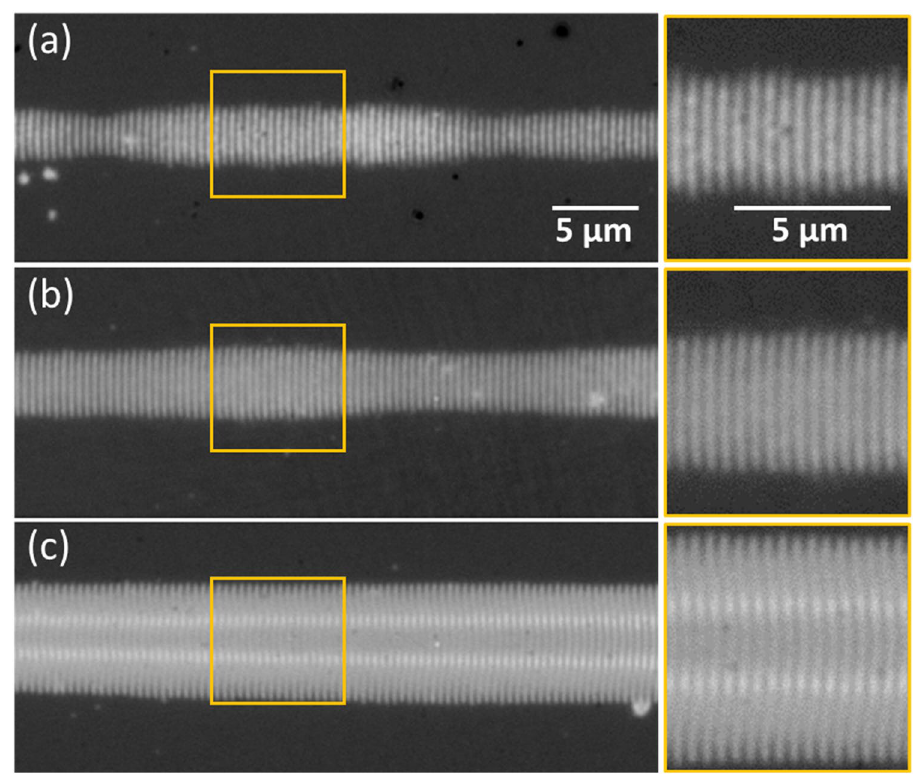
Figure 9. Optical micrographs of lines of short-period amorphous fringes ( Λ s − LIPSS) written at constant fluence ( F = 180 mJ / cm 2 ) but different scanning speeds ( a ) v = 320 µ m / s , N eff = 33 ( b ) v = 300 µ m / s , N eff = 35 ( c ) v = 250 µ m / s , N eff = 42